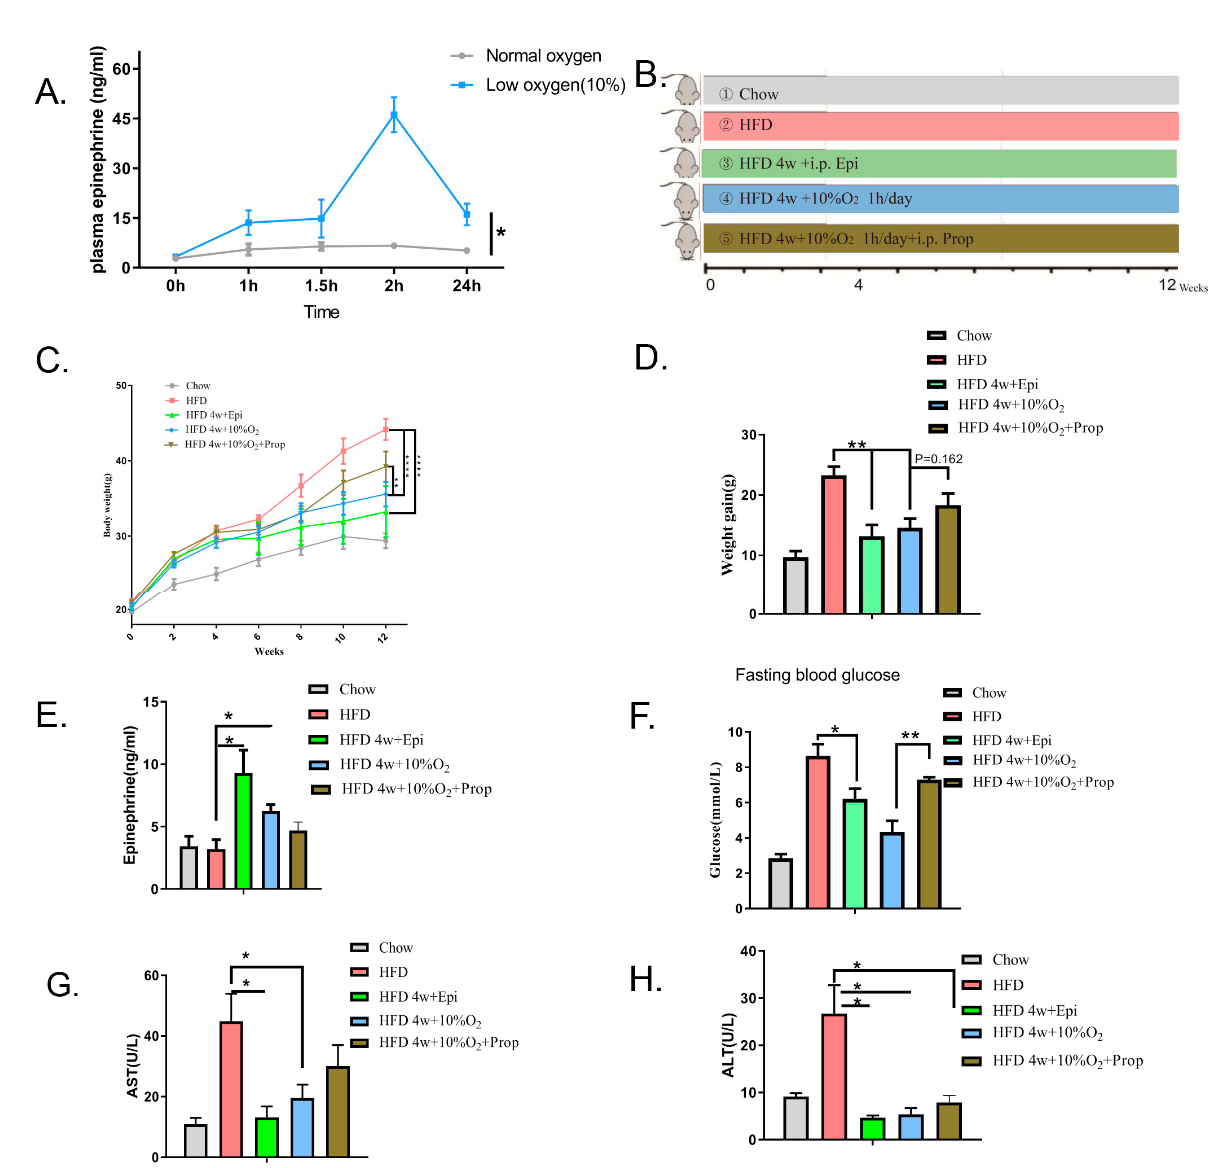
Figure 4. The role of epinephrine in hypoxia-induced changes. ( A ) Chow diet-fed mice were subjected to hypoxia or normoxia for one hour (starting from 0 to 1 h), and serum levels of epinephrine were measured using the ELISA kit. Significance was assessed by two-way ANOVA (mean ± SEM, n = 3). * p < 0.05. ( B ) Scheme of grouping. Mice were divided into 5 groups ( n = 8 per group). (1) Chow diet and normoxia, (2) HFD and normoxia, (3) HFD for 4 weeks and then i.p. injection of epinephrine (0.1 mg/kg/day), (4) HFD for 4 w and then 10% oxygen applied, (5) HFD 4 w and then 10% oxygen applied and propranolol (Prop) (2 mg/kg/day) i.p. injected. ( C ) Changes in bodyweight were recorded and statistical analysis performed using two-way ANOVA (mean ± SEM). ** p < 0.01. **** p < 0.001. ( D ) The value of weight gain was obtained by subtracting bodyweight at the starting point from the endpoint (mean ± SEM, n = 8, t -test). ** p < 0.01. ( E ) Serum concentrations of epinephrine at the endpoint (mean ± SEM, n = 5, t -test). * p < 0.05. ( F ) Fasting blood glucose in mice (mean ± SEM, n = 8, t -test). * p < 0.05. ** p < 0.01. ( G , H ) Serum levels of ALT and AST at the end of experiments (mean ± SEM, n = 5, t -test). * p < 0.05.